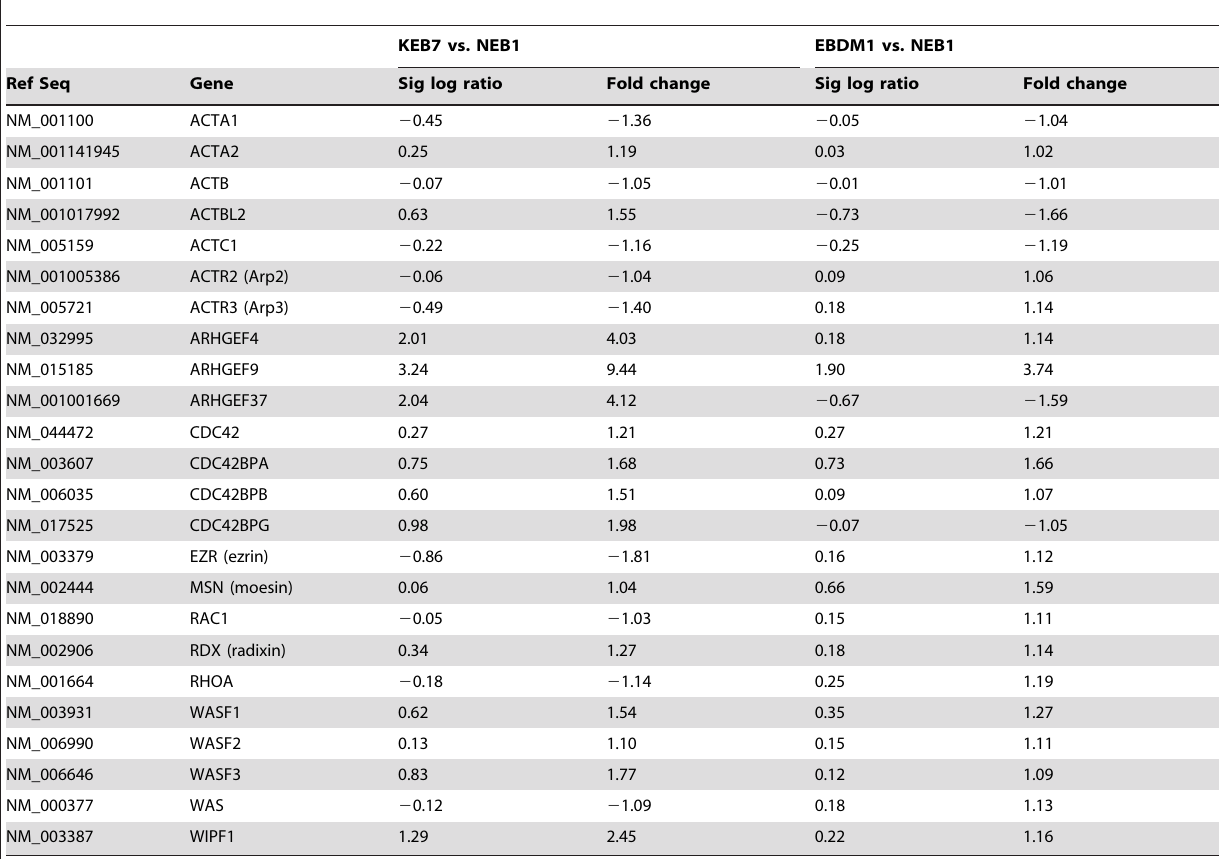
Table 4. Microarray analysis of genes involved in actin cytoskeleton dynamics.